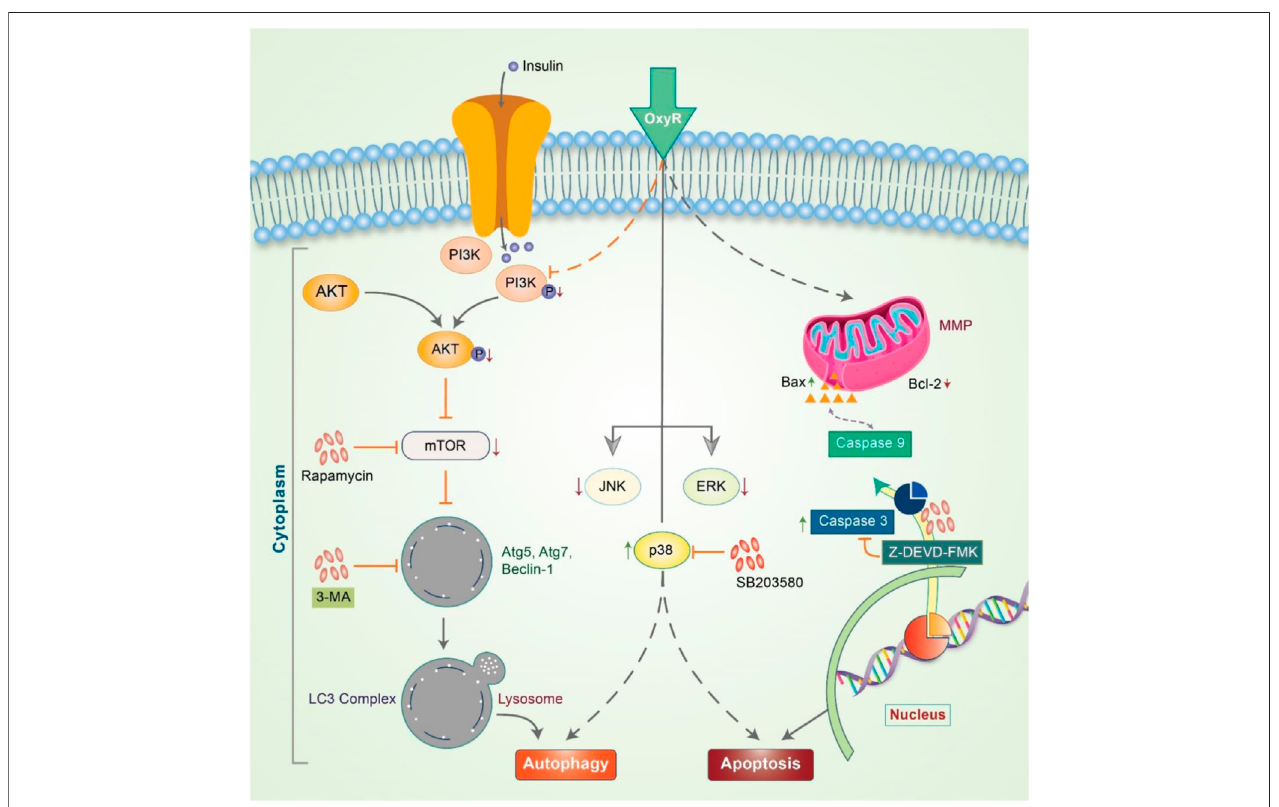
FIGURE5| Oxyresveratrol controls theautophagy-apoptosissignal tomodulate neuroblastomacells. OxyR activates PI3K/Akt/mTORand the inhibition ofmTOR by rapamycin blocks autophagy, indicating an mTOR-dependent autophagic pathway. OxyR led to arrest at the G2/M phase of the cell cycle and activated mitochondria-mediated caspase-3 dependent apoptosis. OxyR was also revealed to increase Bax/Bcl-2 ratio without generating ROS or activating p53. When the p38 inhibitor, SB203580, was applied, OxyR was found to activate autophagy-apoptosis signaling in neuroblastoma cells.